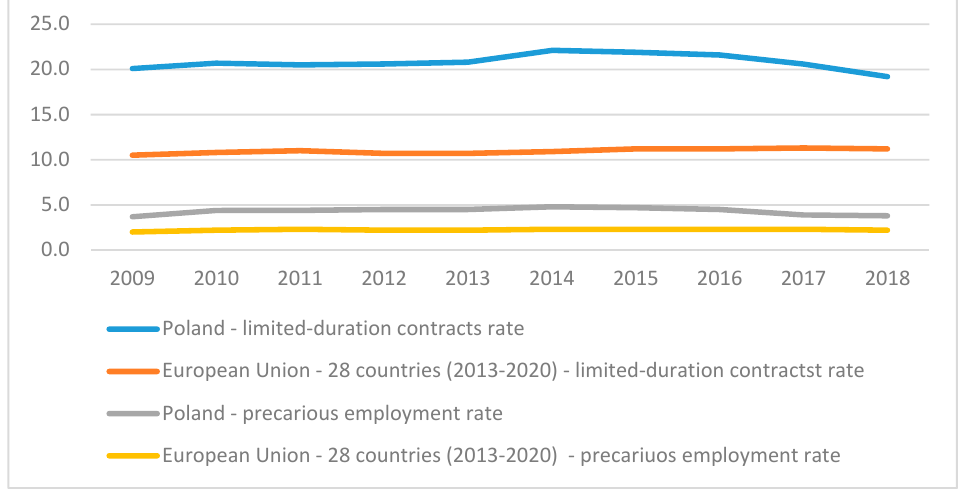
Figure 2. Non-standard employment rate in Poland at the background of the EU average—based on (Eurostat 2019a, 2019b).